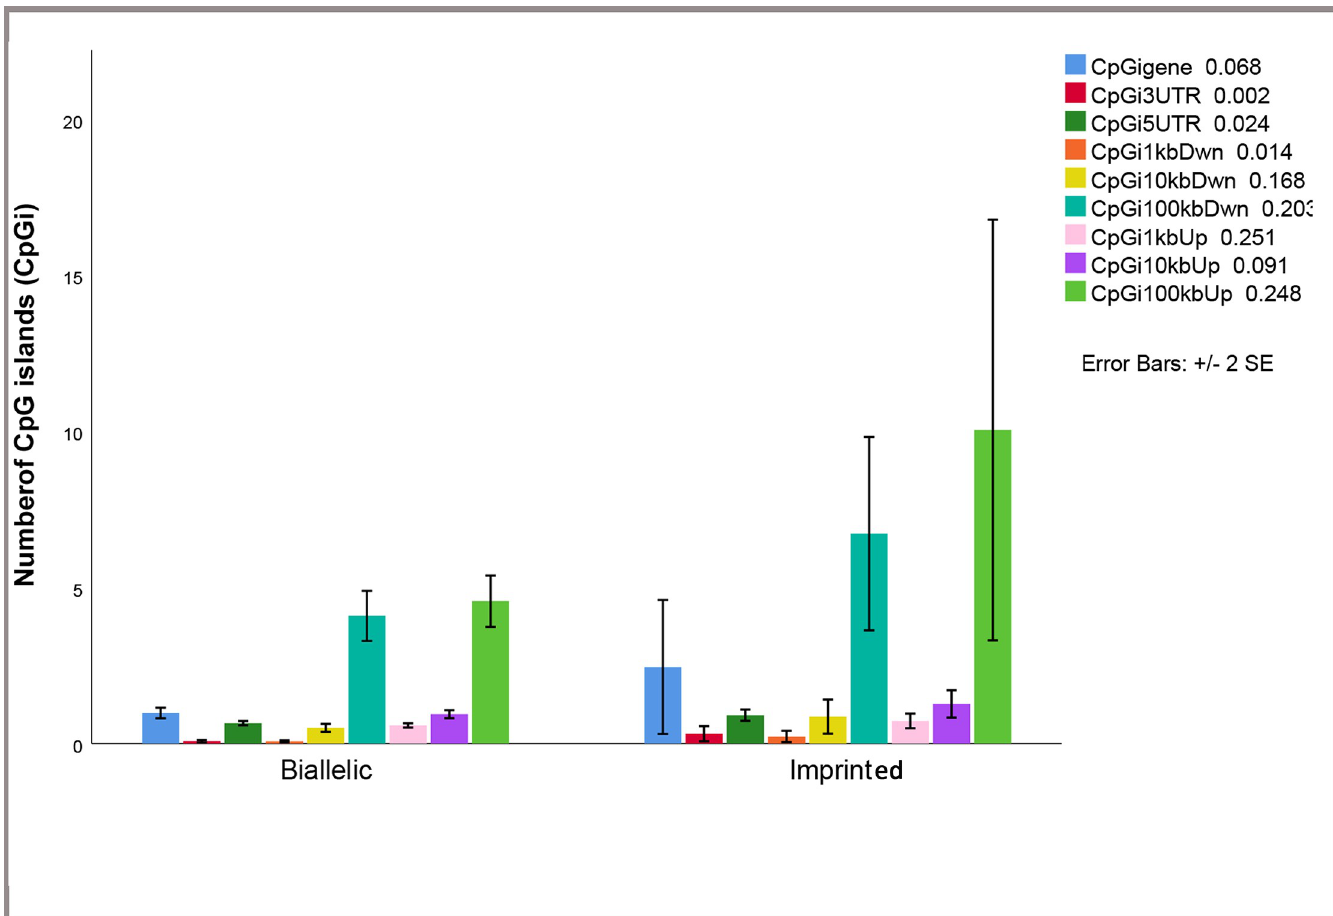
Fig 3. Bar plot of number of CpG (CpGi) in imprinted (M) and biallelic (BI) expressed genes. As shown in the barplot number of CpG islands was different between imprinted and biallelic expressed genes in some studied